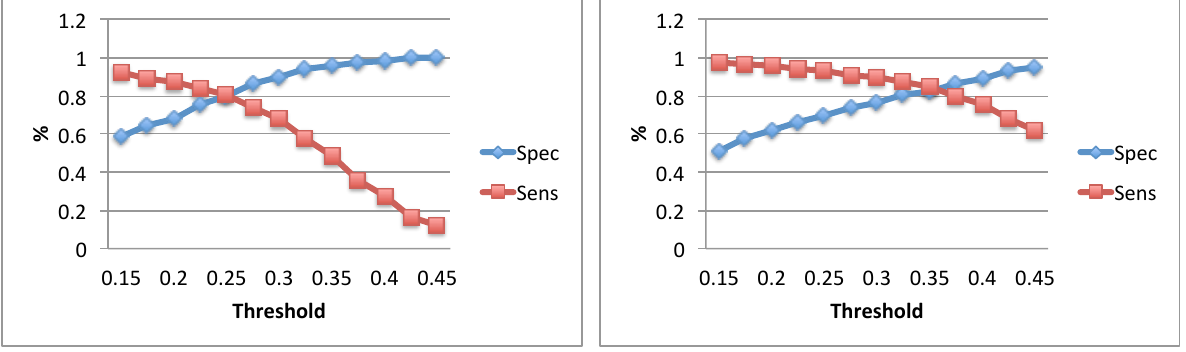
Figure 2. Specificity and sensitivity trends of voiced segmentation in Subject 1 ( left ) and Subject 2 ( right ) regarding the comparison GTal vs. ANDal.